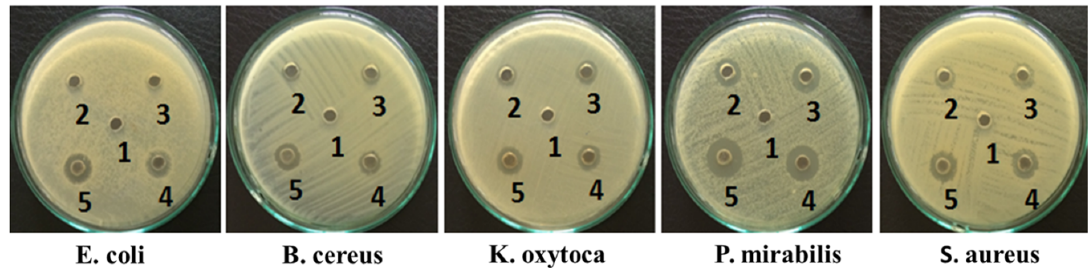
Figure 1. Antibacterial activity of CoL 1 Gly against different bacterial strains.